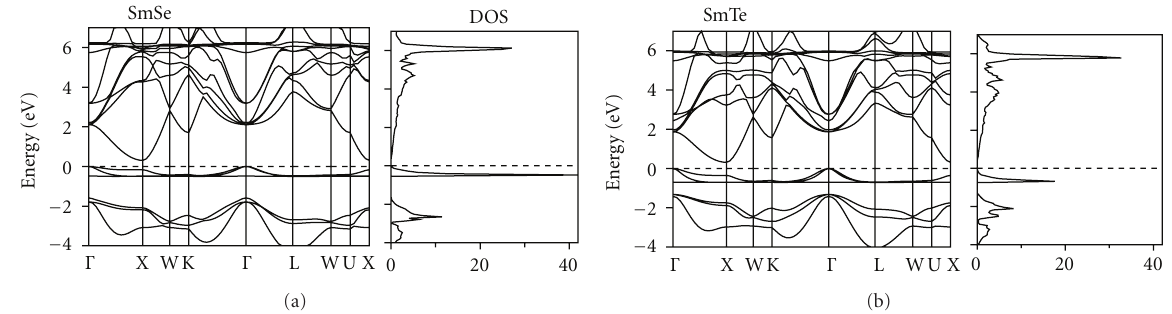
Figure 48: Self-consistent fully relativistic, spin-polarized energy band structure and total DOS (in states/(unit cell eV)) calculated for SmSe and SmTe in LSDA+ U approximation